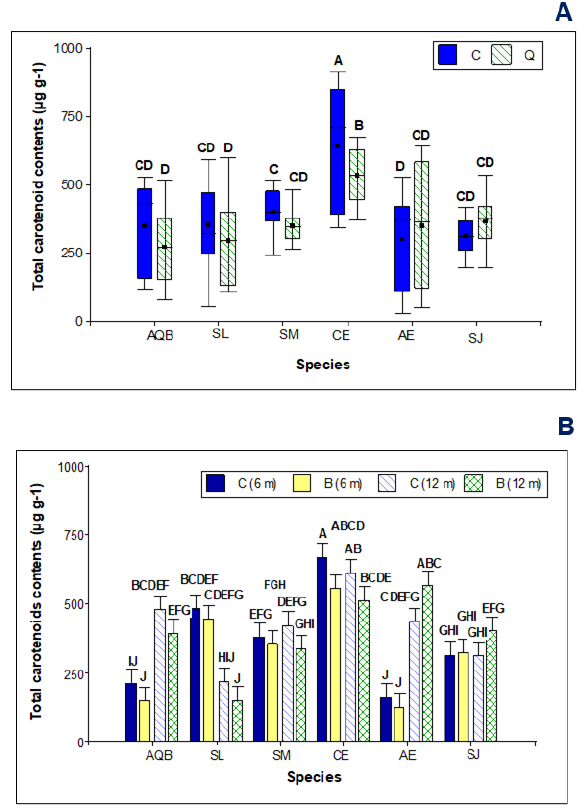
Figure 2. ( A ) Content of total carotenoid in response to EB expressed in µg g − 1 dry weight. In the box plot, the boundary of the box closest to zero indicates the first quartile (Q1), a black line within the box marks the median, a black point within the box marks the mean, and the boundary of the box farthest from zero indicates the third quartile (Q3). Whiskers above and below the box indicate the 10th and 90th percentiles. ( B ) Comparison of total carotenoid contents considering the time elapsed after EB 2016 (6 and 12 months). Different letters indicate significant differences, according to LSD Fisher pairwise comparison procedure with α : 0.05, n = 30 individual plants by treatment each sampling date. In each figure (B) = Burnt plants; (C) = Control plants. References: SM = S. mistol , SJ = S. johnstonii , SL = S. lorentzii , AE = A. emarginata , AQB = A. quebracho-blanco , CE = C. ehrenbergia.na